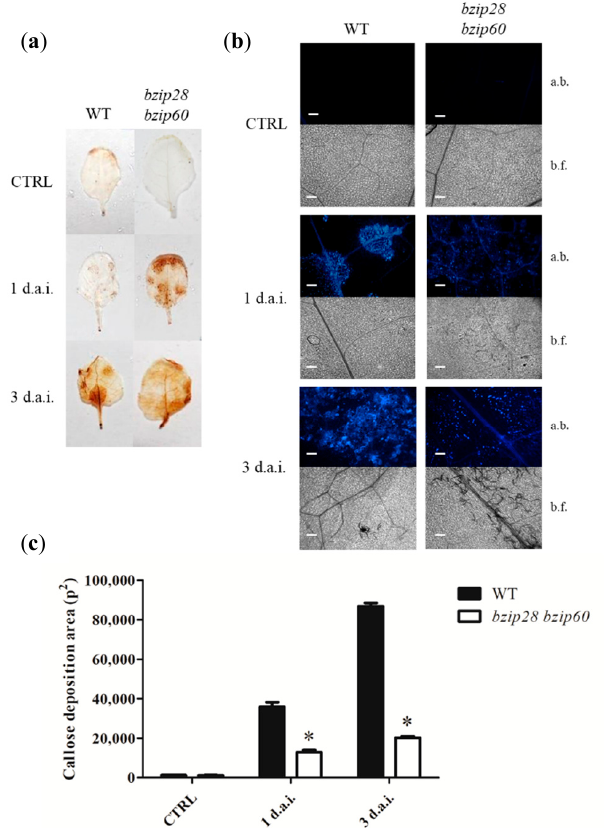
Figure 3. In situ H 2 O 2 production ( a ), and callose deposition ( b , c ) in leaves of WT and bzip28 bzip60 mutant Arabidopsis plants infected with D. gigantea . ( a ) Optical microscope images of leaves of WT and bzip28 bzip60 mutant plants. Leaves were collected 1 and 3 d.a.i., stained with DAB as reported in Section 2.6 and observed using an optical microscope at 4 × magnification; bar = 200 µ m. Images are representative of three independent experiments. ( b ) Fluorescence microscope images of leaves from WT and bzip28 bzip60 mutant plants sprayed with a suspension of D. gigantea conidia (500,000/mL). The leaves were collected 1 and 3 d.a.i., stained with 0.01% aniline blue and observed using a fluorescence microscope at 10 × magnification as reported in Section 2.7. Images are representative of three independent experiments; a.b., aniline blue; b.f., bright field. ( c ) Callose deposition area as derived from images reported in ( b ), following analysis with ImageJ software. The results represent mean values ± SDs ( n > 10). Statistical significance was attributed by Student’s test (* p <